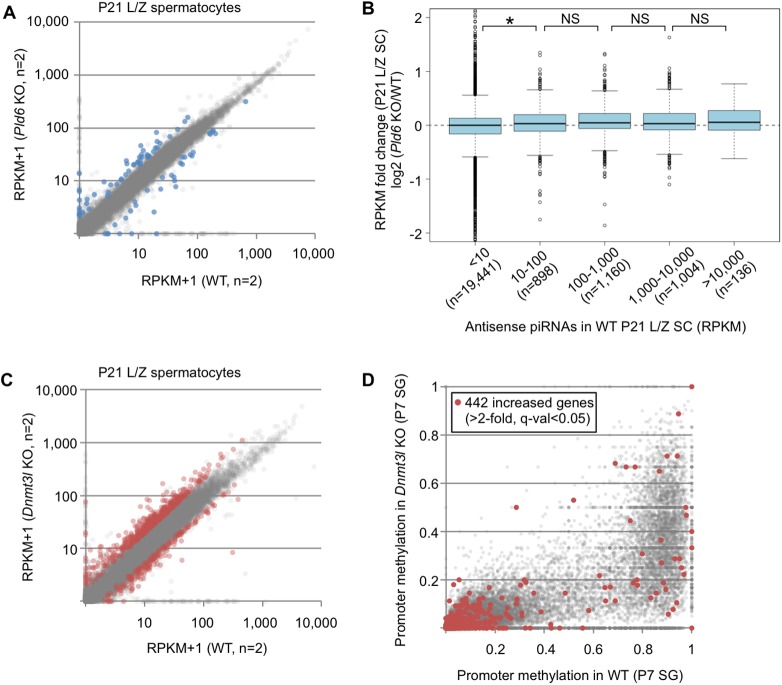
RefSeq gene expression profiles in Pld6 KO and Dnmt3l KO spermatocytes.(A) Expression of protein-coding and noncoding genes (n = 22,771, excluding miRNAs, small nucleolar RNAs, and rRNAs) in Pld6 KO and WT spermatocytes. Genes showing increased or decreased expression in Pld6 KO spermatocytes are colored in blue (>2-fold or <1/2, q-value < 0.05). (B) Relationship between the increase in RefSeq gene expression in Pld6 KO spermatocytes and the abundance of piRNAs antisense to the genes in WT spermatocytes. Genes are grouped according to the abundance of antisense piRNAs (RPM). The box plot features are as described in Fig 3D. An asterisk indicates that the difference is significant (P < 0.05, U test). NS, not significant. (C) Expression of protein-coding and noncoding genes in Dnmt3l KO and WT spermatocytes. Genes showing increased or decreased expression in Dnmt3l KO spermatocytes are colored in red (>2-fold or <1/2, q-value < 0.05). (D) Promoter methylation levels in Dnmt3l KO and WT spermatogonia. The red spots indicate the promoters of genes showing increased expression in Dnmt3l KO spermatocytes (>2-fold, q-value < 0.05).